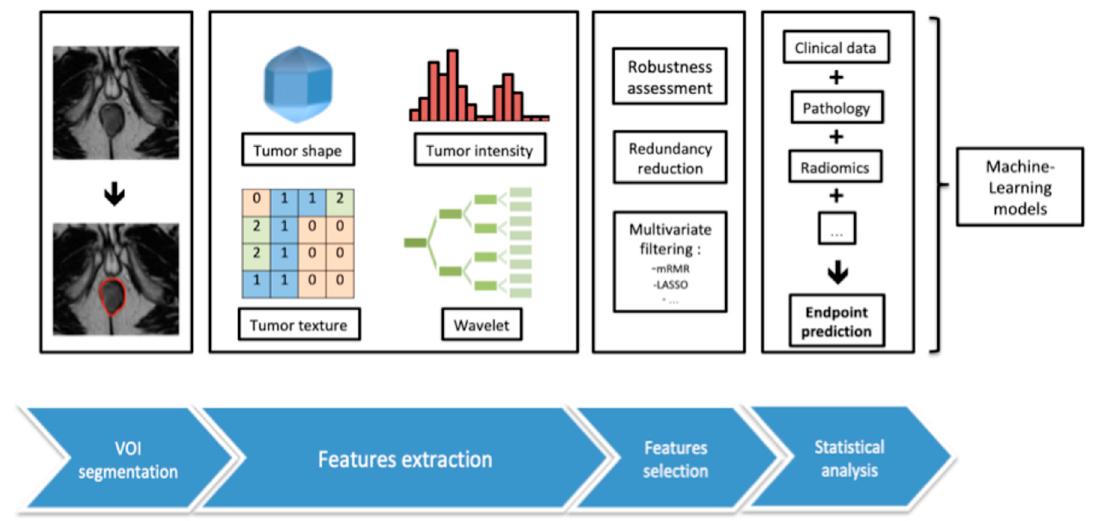
Figure 1. Radiomics workflow and incorporation in anal cancer prediction models .